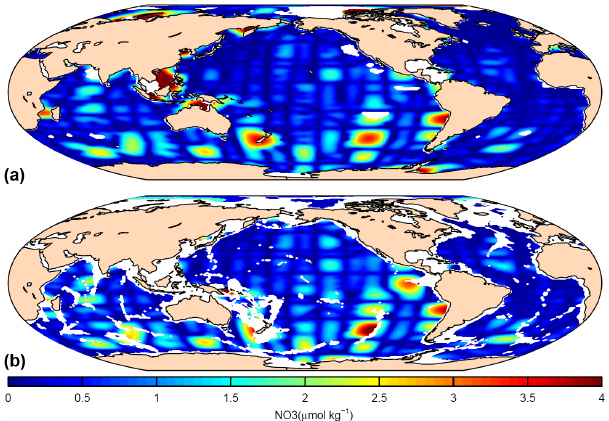
Figure 11. Mapping error for nitrate at 10m (a) and 3000m (b) . Notice how the error increases with distance from transects, creating a spatial pattern of square-like features in the Pacific.